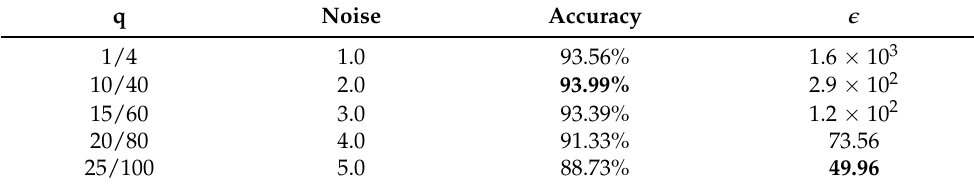
Table 12. The robustness of differential privacy on symptom